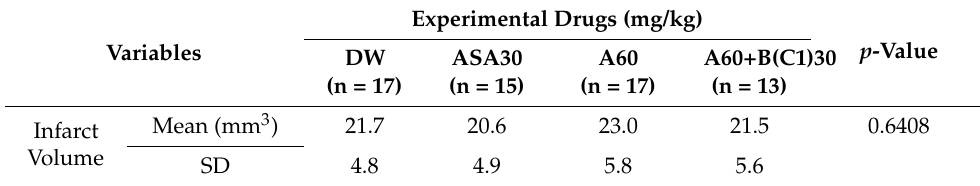
Table 3. Effects of experimental drug A60+B(C1) 30 mg/kg on infarct volume after pMCAO.